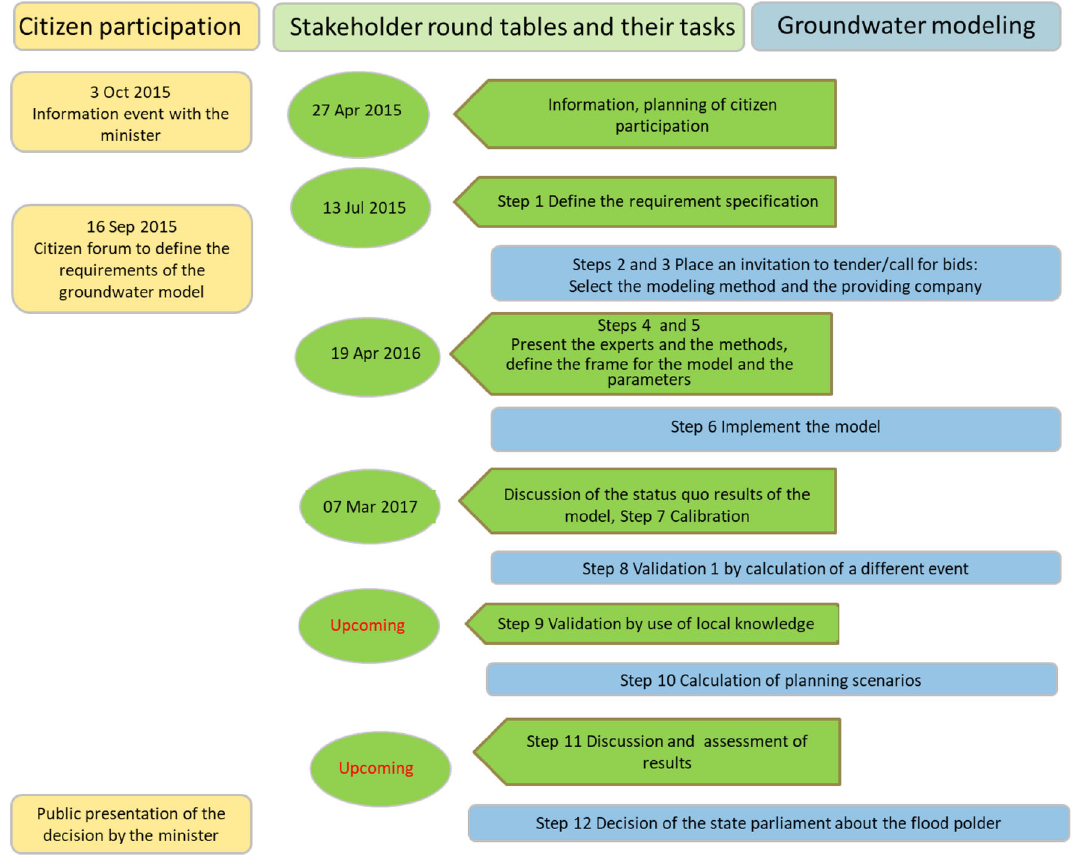
Fig. 3 The participatory modeling process in the Katzau polder case study near Ingolstadt in Bavaria,